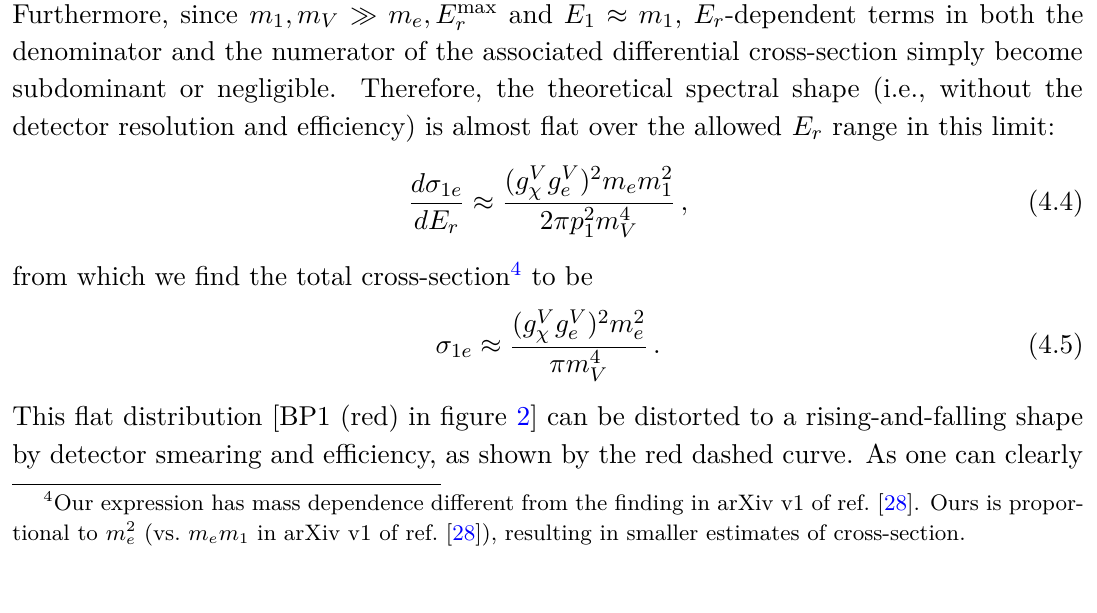
) are the r = 0 . 45 keV) and efficiency reported in ref. [38] res